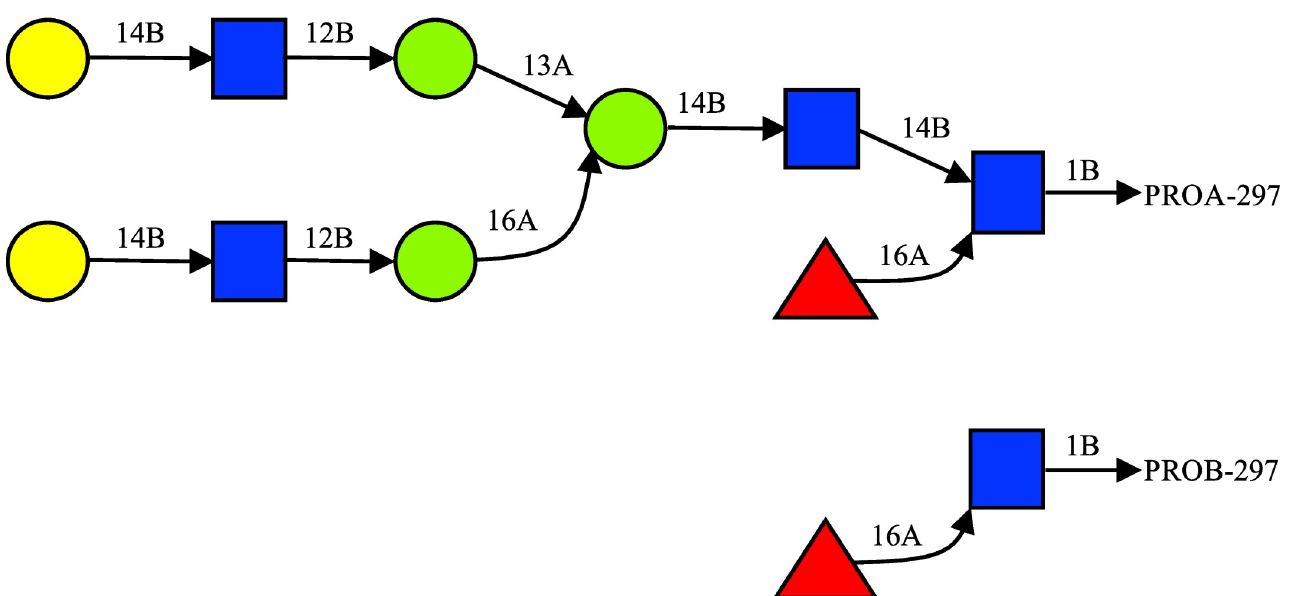
Fig 13. Complex Type (CT) glycan used in this study. In the case of monoglycosylated Fc, at the second glycosylation site the first monosaccharide and the attached Fucose were maintained to model the digested glycan as